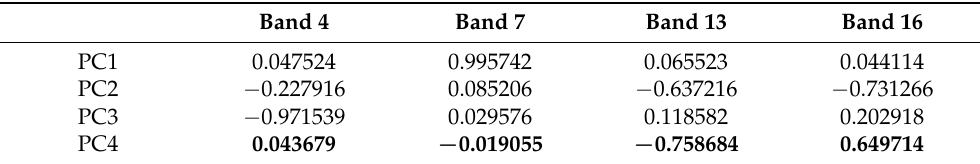
Table 5. Eigenvector matrix of the chlorite by PCA method.